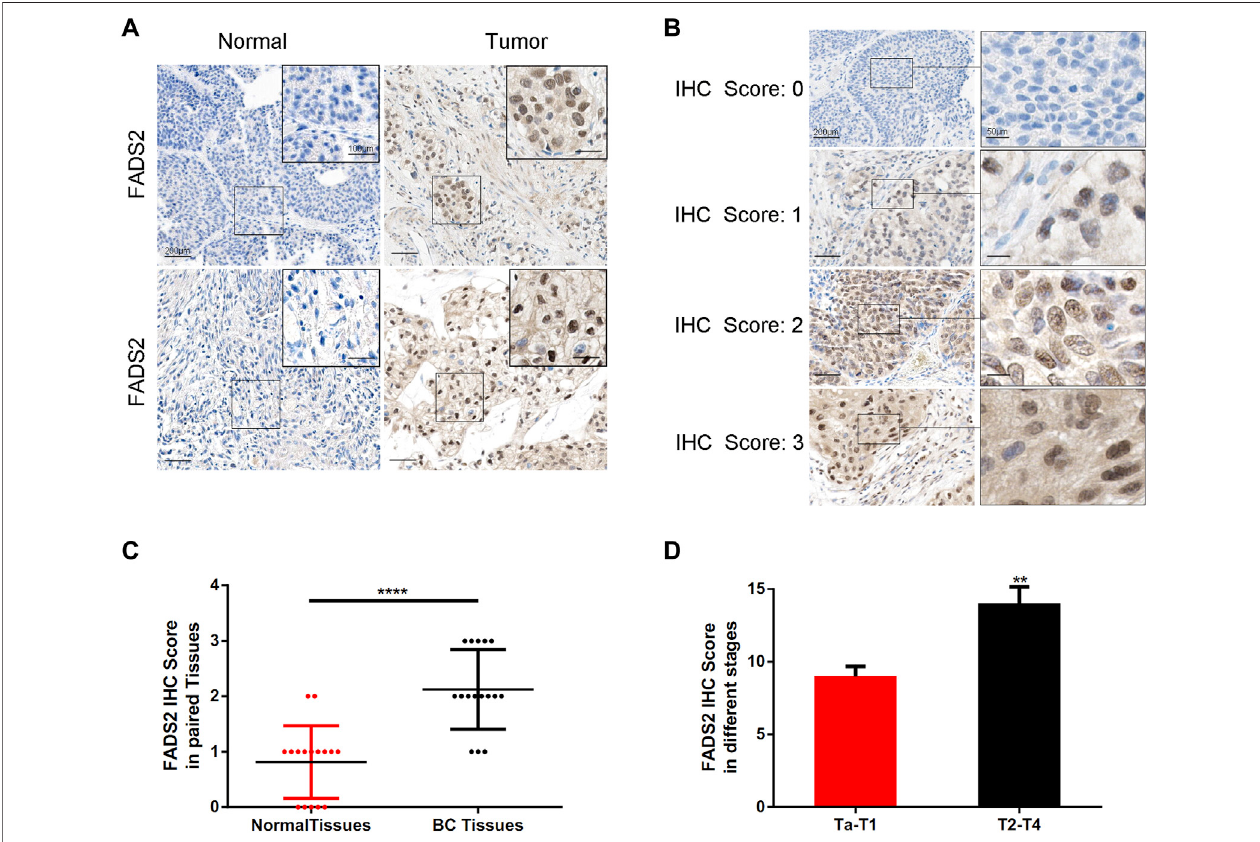
FIGURE11| DetectionofFADS2protein expressionintissuesbyIHCstaining. (A) IHCofFADS2innoncanceroustissuesandbladdercancertissuesof2patients with different tumor grades. The scale bars represent 200 μ m and in the inserts 100 μ m. (B) IHC of FADS2 in bladder cancer tissues. IHC scoring was performed accordingtothestainingintensity(0,negative;1,weak;2,moderated;3,strong).Thescalebarsrepresent200 μ mandintheinserts50 μ m. (C) FADS2wassigni fi cantly increased in primary tumor specimens compared with adjacent non-tumor tissues by IHC. ( p < 0.0001) (D) FADS2 was signi fi cantly increased in tumor tissues of T2-T4 stages compared with Ta-T1 stages by IHC. ( p <